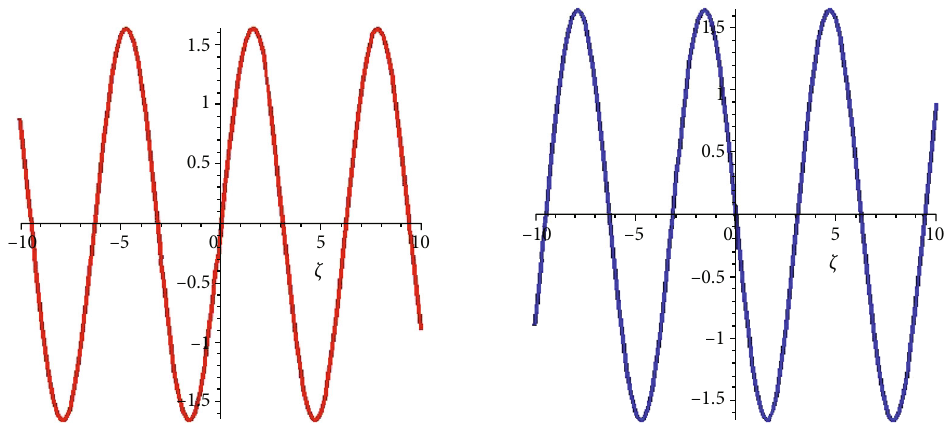
Figure 1: YDM solutions of μ ð ζ , Ψ Þ and ν ð ζ , Ψ Þ for example 1 at δ = 1